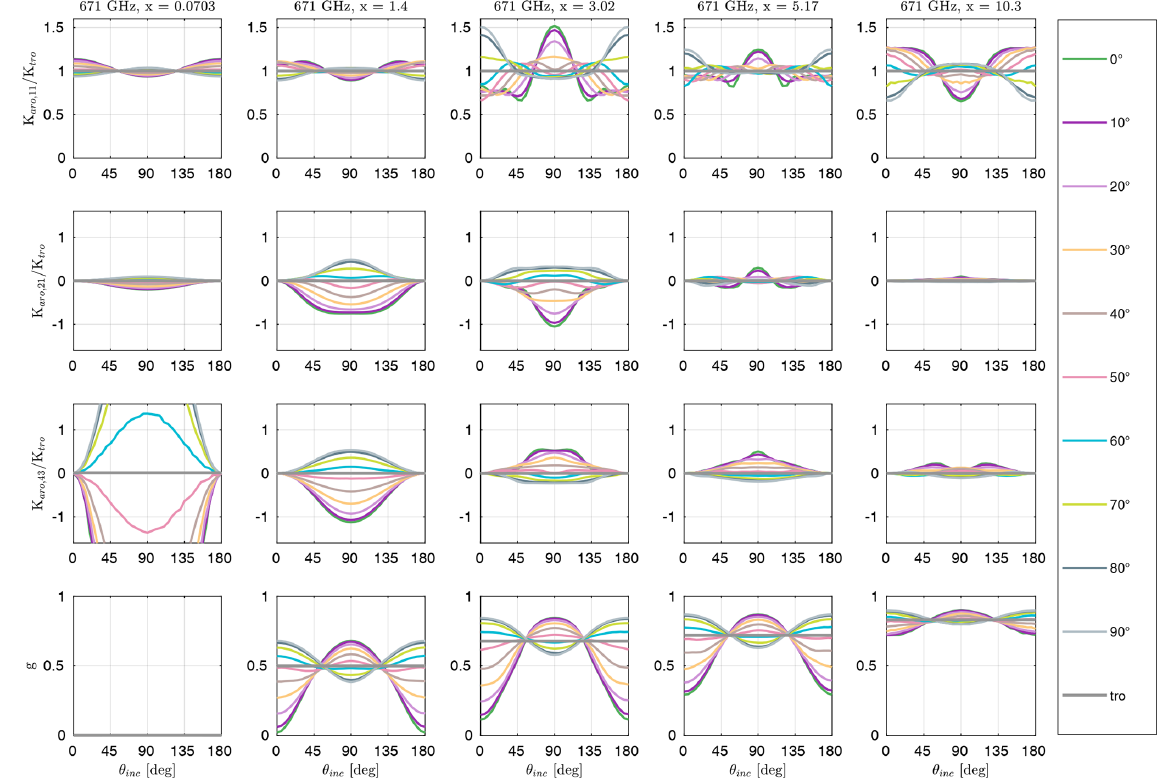
Figure 7. Extinction matrix elements K aro ,ij normalized by the extinction cross section for total random orientation and the asymmetry parameter g of plate type 1 (hexagonal plate) for different size parameters x at 671GHz, as a function of incidence angle θ inc for several tilt angles β . The gray lines denote total random orientation. The shapes of the scatterers are shown in Fig.